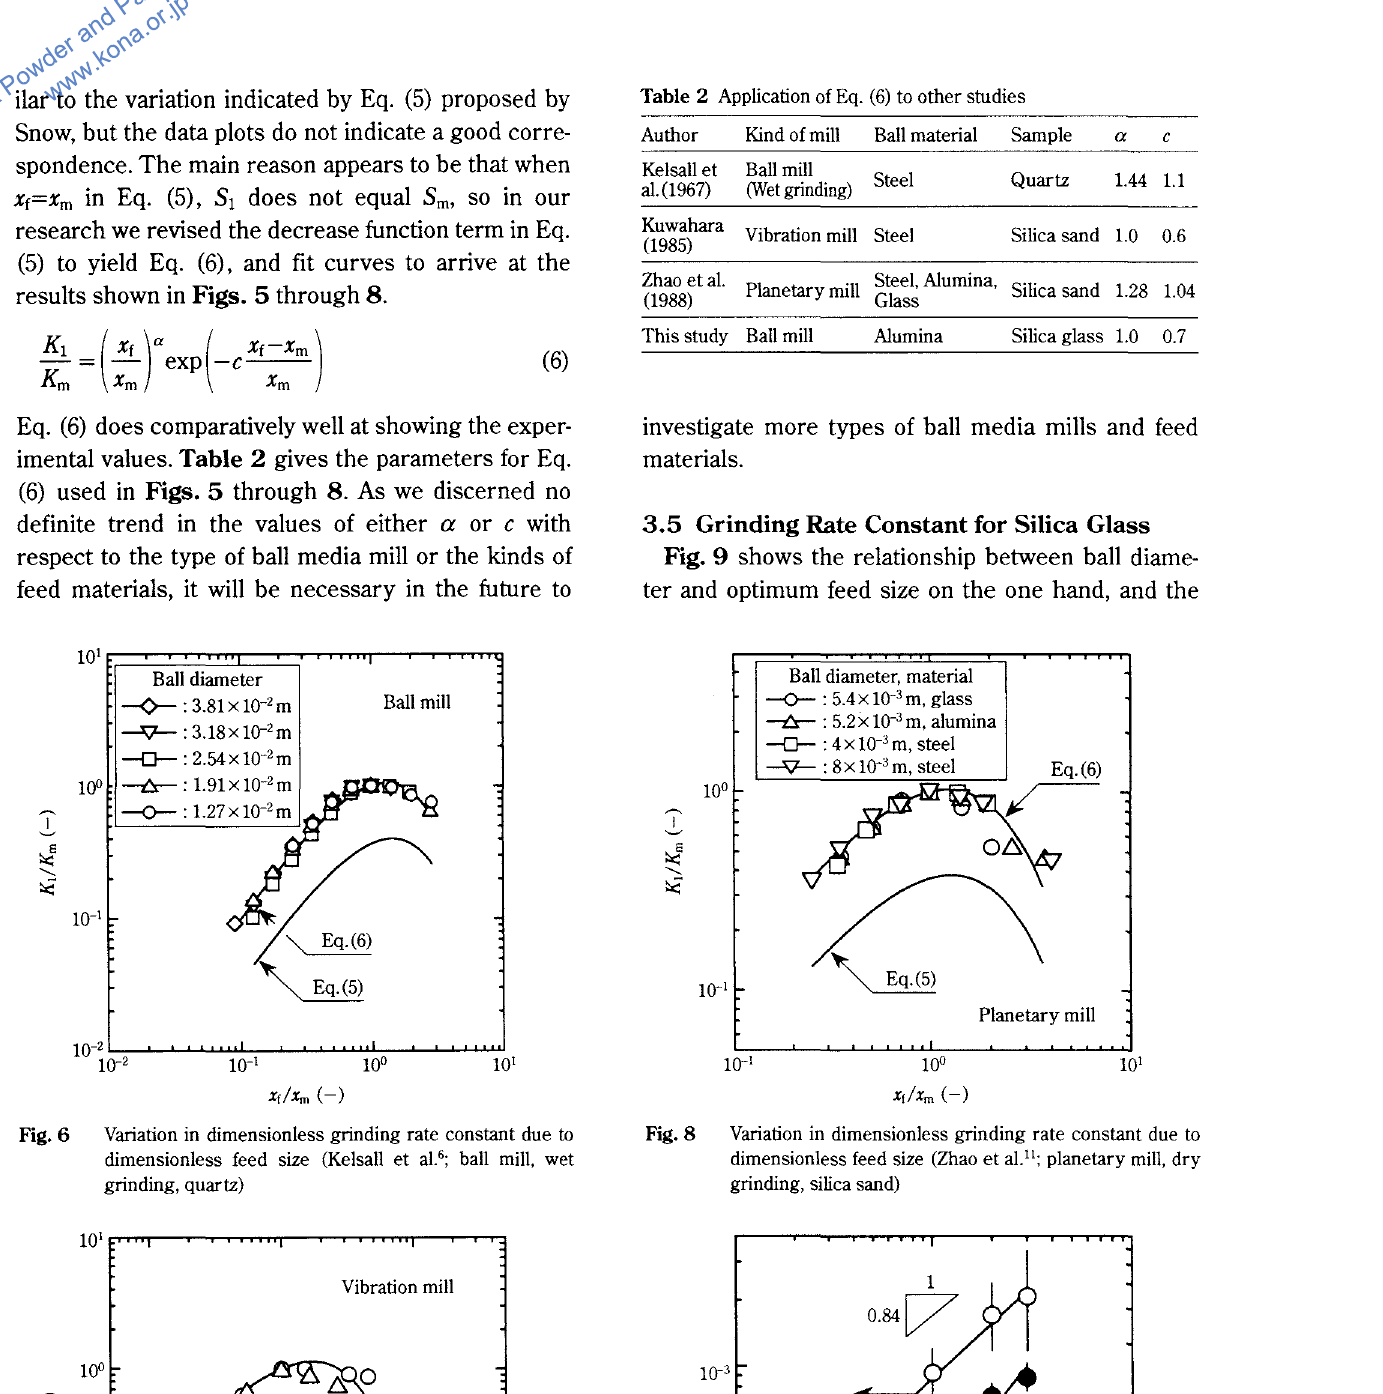
Table 2 Application of Eq. (6) to other studies